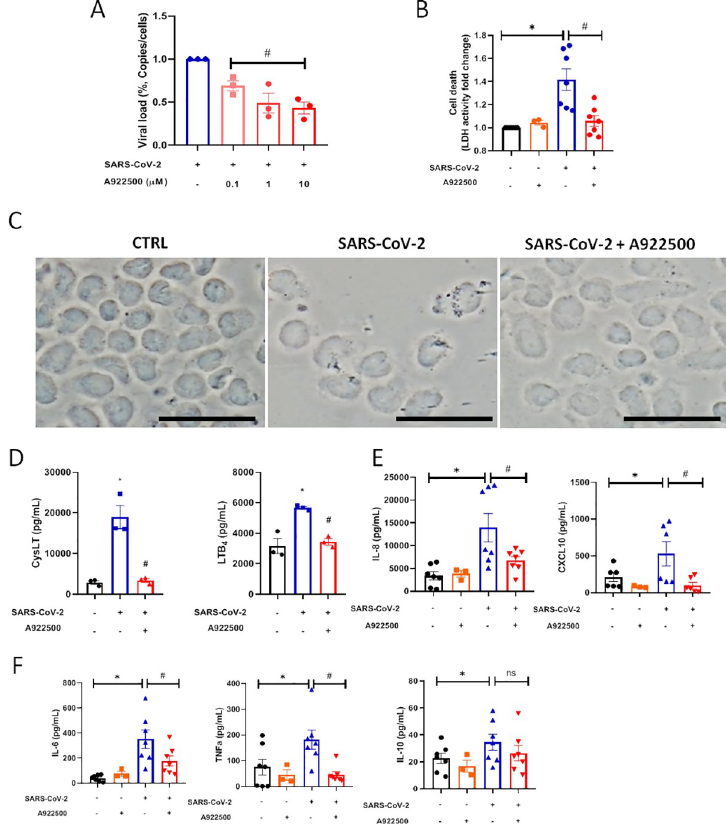
Fig 3. DGAT-1 Inhibitor A922500 decreases the pro-inflammatory profile and cell death induced by SARS-CoV-2 infection and reduces the viral load in human monocyte. Monocytes were pre-treated with DGAT-1 inhibitor A922500 in different concentrations (0.1, 1 and 10 μ M) for 2 hours before the infection with SARS-CoV-2 with MOI of 0.01 during 24h in presence of the inhibitor. (A) Cell death was measured in the supernatant by LDH activity fold change in relation to the uninfected cell. (B) Viral load by qPCR. Monocytes of each sample were counted for normalization. (C) Images of phase contrast from monocytes. Scale bar 20 μ m. (D-F) The inflammatory cytokines were measured in supernatants by ELISA (D) leukotrienes: CysLT and LTB 4 , (E) chemokines: IL-8 and CXCL10, (F) inflammatory cytokines: IL-6, TNF- α and IL-10. Data are expressed as mean ± SEM obtained in three independent donors for viral replication, leukotrienes and the group A922500 alone, and seven independent donors for the other groups. � p < 0.05 versus uninfected cells and #p < 0.05 versus infected cells. and LD inhibition with 10 μ M of A922500 was able to inhibit SARS-CoV-2-induced cell death (Fig 3B and 3C).